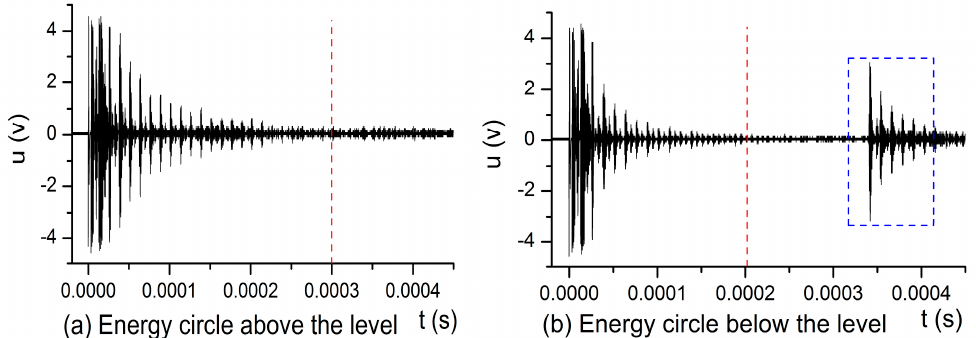
Figure 7. ( a ) The energy circle is above the liquid level; and ( b ) the energy circle is below the liquid level, with the thickness of a metal wall being 50 mm.